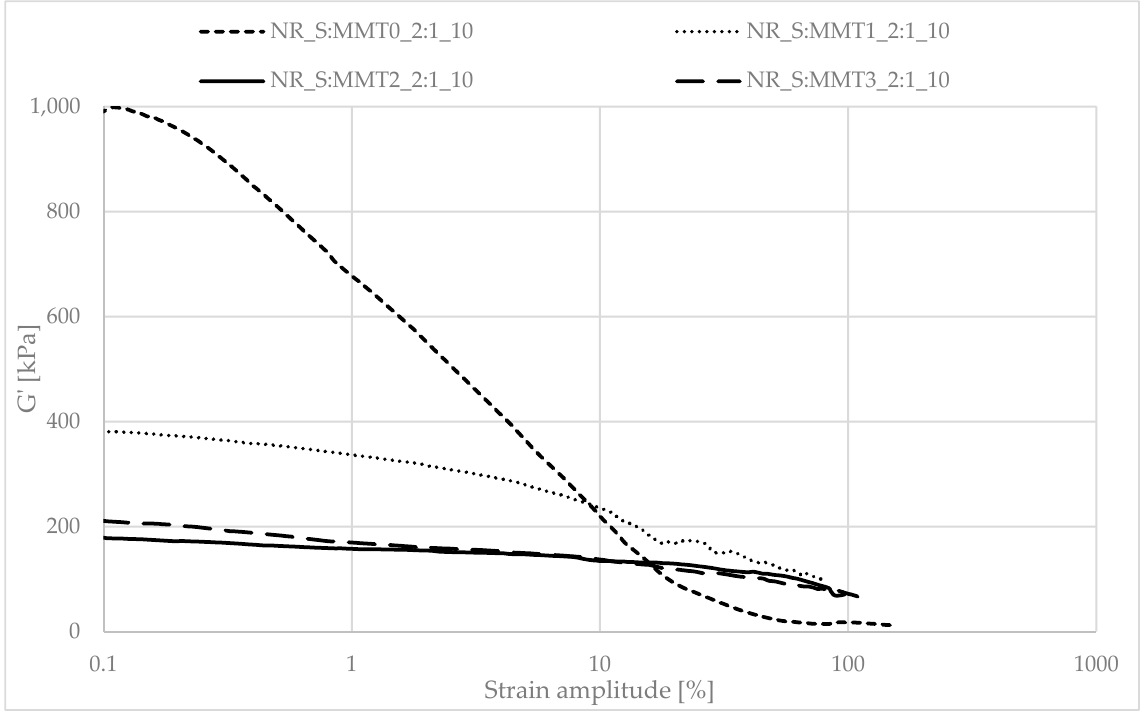
Figure 7. Dependence of the storage module as a function of the strain amplitude for natural rubber composites filled with straw:montmorillonite filler (10 phr), 2:1 ratio.